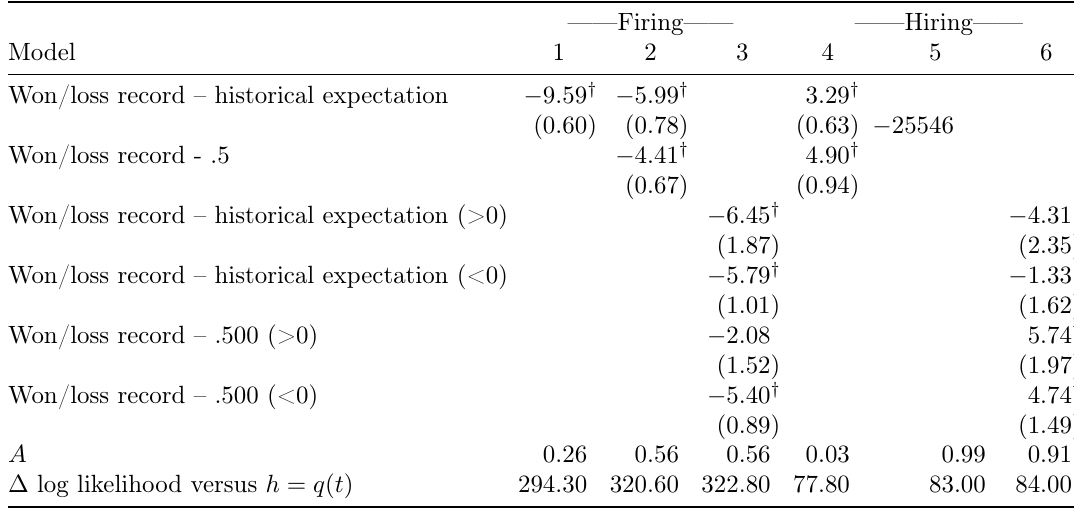
Table 4: Expectations-based models: Partial likelihood estimates of the hazard of firing and hiring field managers in Major League Baseball, 1900-2008 ——Firing——